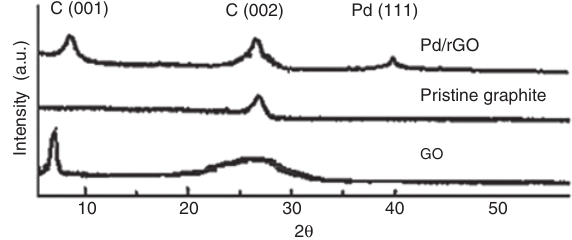
Figure 2: X-ray diffraction (XRD) analysis of graphene oxide (GO), pristine graphite and Pd/reduced GO